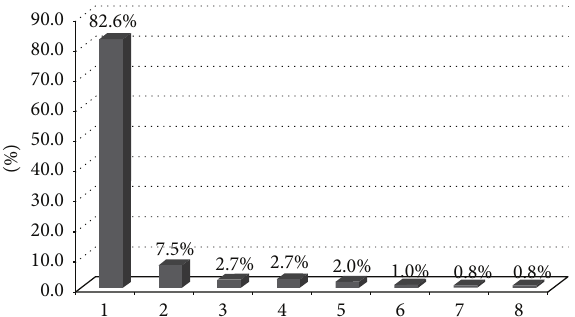
Figure 2: Percentages (%) of ESTs related to gene function in the MRT-SSH library. (1) Unknown genes; (2) neuropeptide hormone/hormone transporter; (3) ribosome protein; (4) RNA binding protein; (5) hypothetical protein; (6) related to develop- ment/communication; (7) immune related; (8)